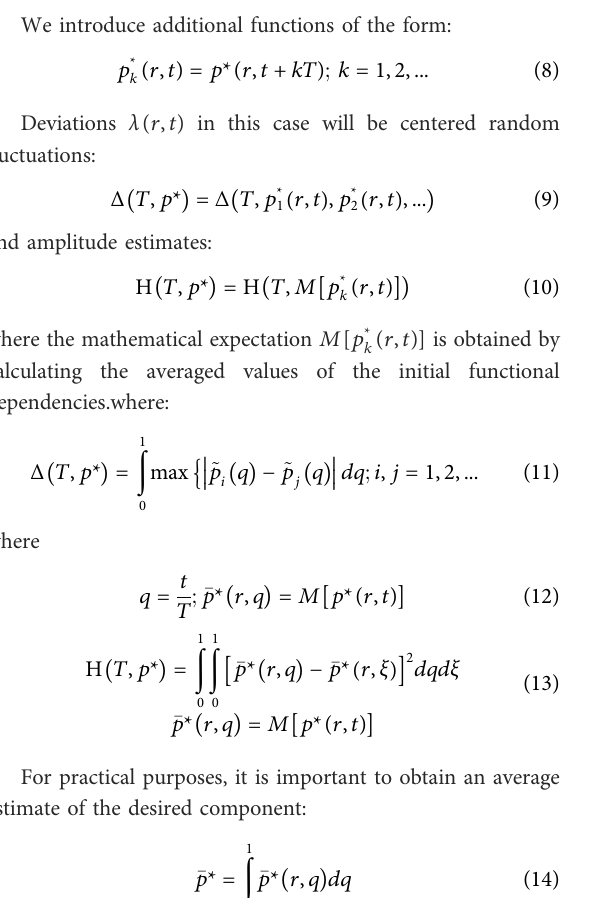
FIGURE 2 Innovation index dynamics in climate change in 2014 – 2021 in